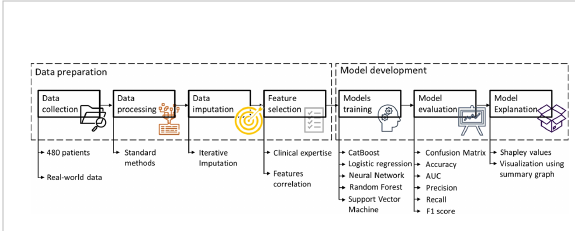
FIGURE 2 Methodology work fl ow for developing different ML/XAI models. AUC, area under the